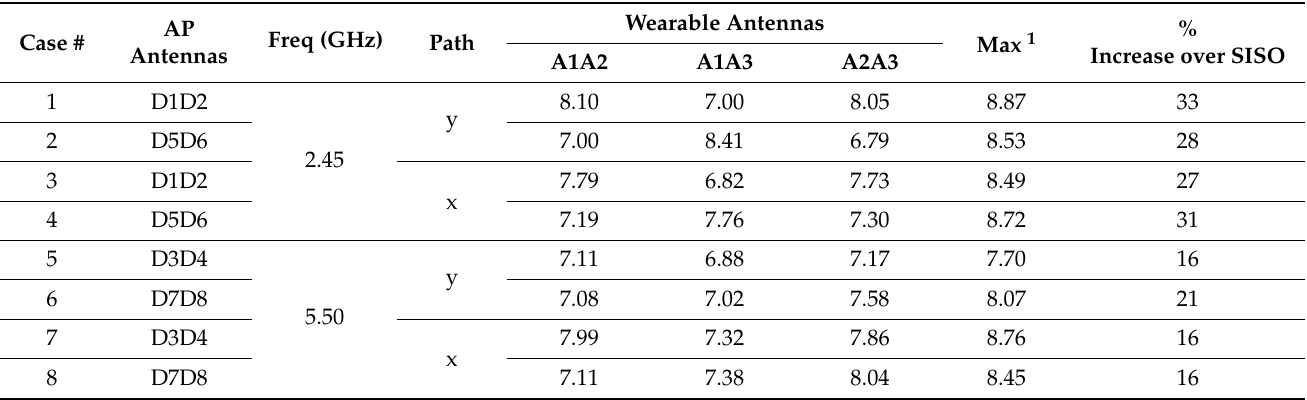
Table 5. Summary of the capacity of 2 × 2 MIMO combination when the person moves along the x or y directions, all capacity values are in